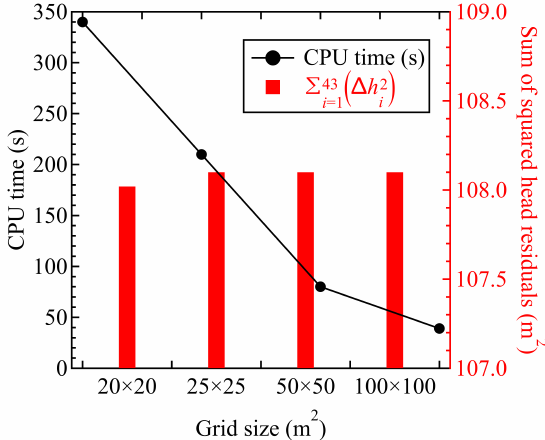
Figure 5. The black curve shows the time taken to run a single simulation across different grid resolutions. The bars indicate the squared difference between observed and simulated hydraulic heads and they are all about equal for piecewise homogeneous hydraulic